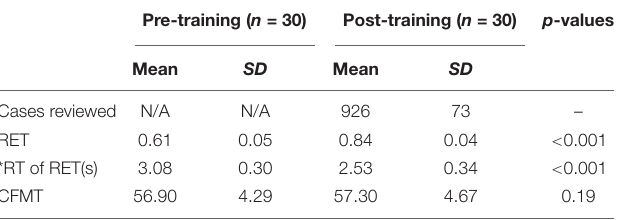
TABLE 1 | The results of behavioral tasks within the subjects pre- and post-training. Pre-training ( n = 30) Post-training ( n =